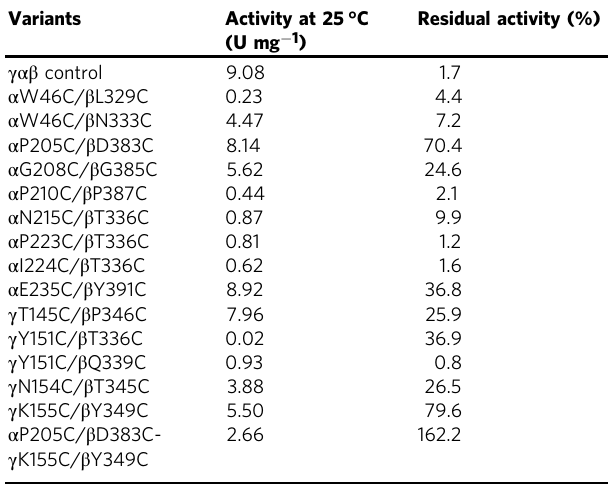
Table 1 Residual activity after treatment at 65 °C for 15